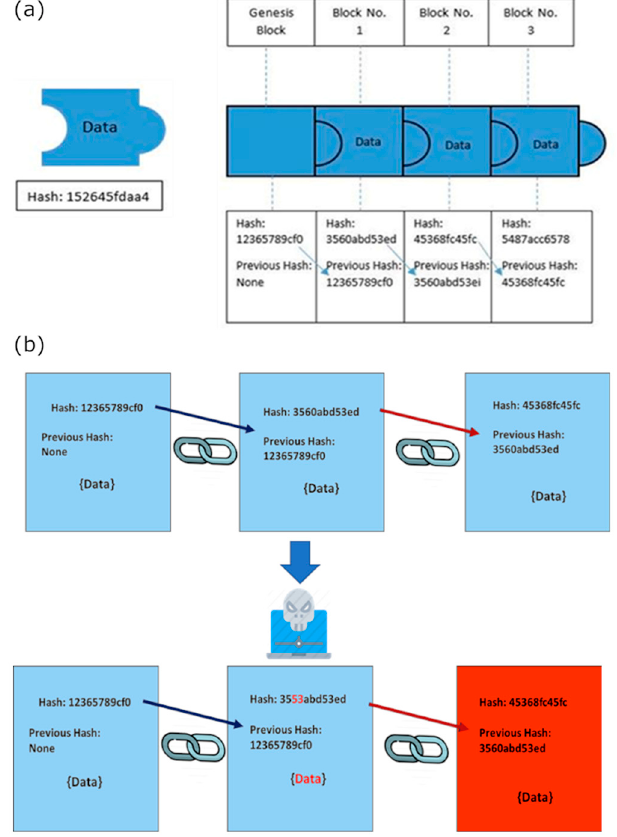
Figure 1. The SHA-256 hashing technique. ( a ) The mechanism of the cryptographic linking in the blockchain that grants security within the decentralization system. ( b ) The attack detection by the hashing system.